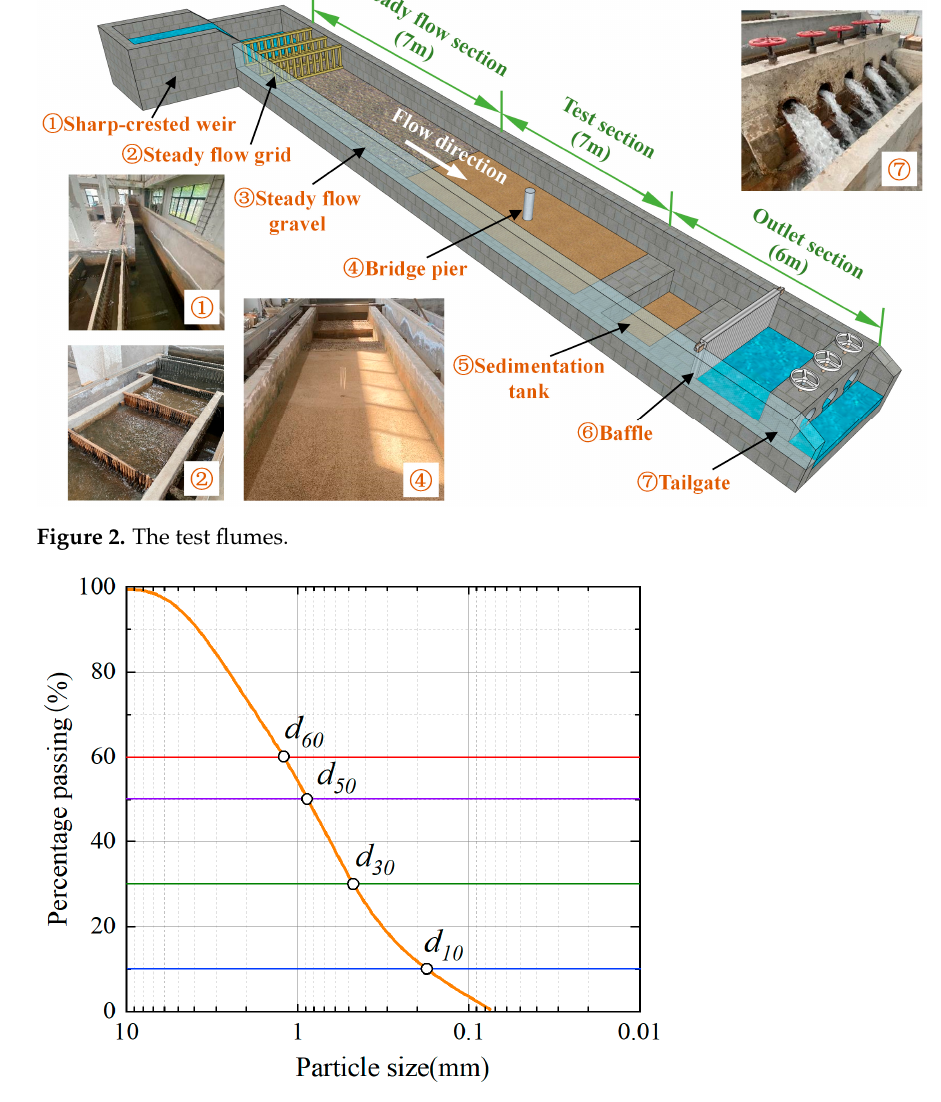
Figure 3. Gradation curve of the sand.